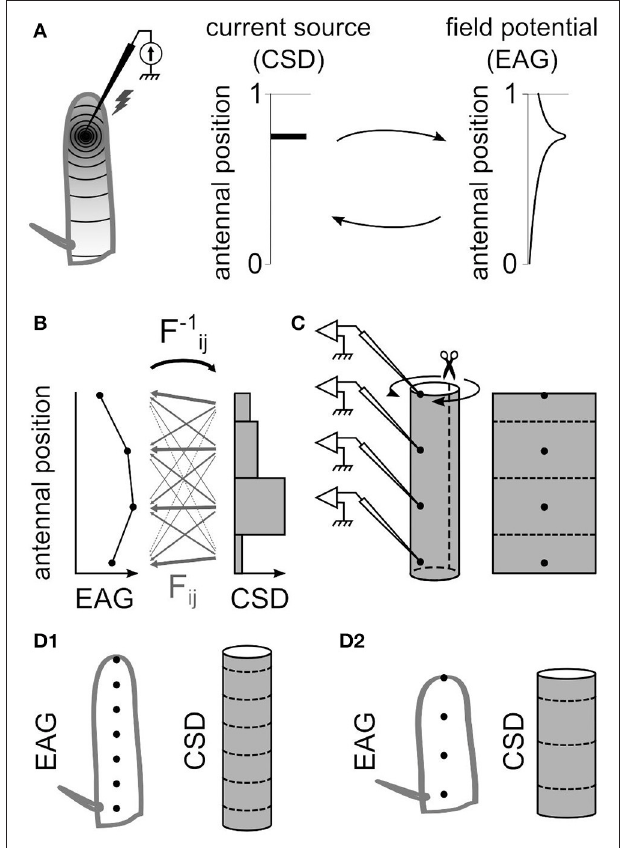
FIGURE 1 | The antennal model for estimating current source density. (A) Electrostatic principles on the insect antenna. Left, a source of current at a given position on the funiculus is schematized. A static source of current at a specific antennal locus (middle) induces an electric field along the antenna that gets weaker with the distance from the source (right). The distribution of current sources and the distribution of potentials can be reciprocally deduced from each other. (B) For a model with four EAG positions, the CSD is estimated in four compartments. The EAG linearly depends on the CSD, and the 4 × 4 linear coefficients F ij are symbolized with gray arrows. The thickness of each arrow symbolize the strength of the coefficient: it is small for the current sources far from the recording site, and it is large for the current sources close to the recording site. The reciprocal coefficients F − 1 ij could be detailed in the same way. (C) The model of funiculus is a cylinder with the recording positions located on the surface (left). The current sources are on the surface only, and only the surface is considered conductive. Hence, the surface of the cylinder was virtually unfolded (right) and subdivided in the same number of compartments than the number of recording sites. (D) The dimensions of the cylinder that models the funiculus was different for each species. The figures show a model for an elongated funiculus with seven recording positions (D1) and for a globular funiculus with four recording positions (D2)